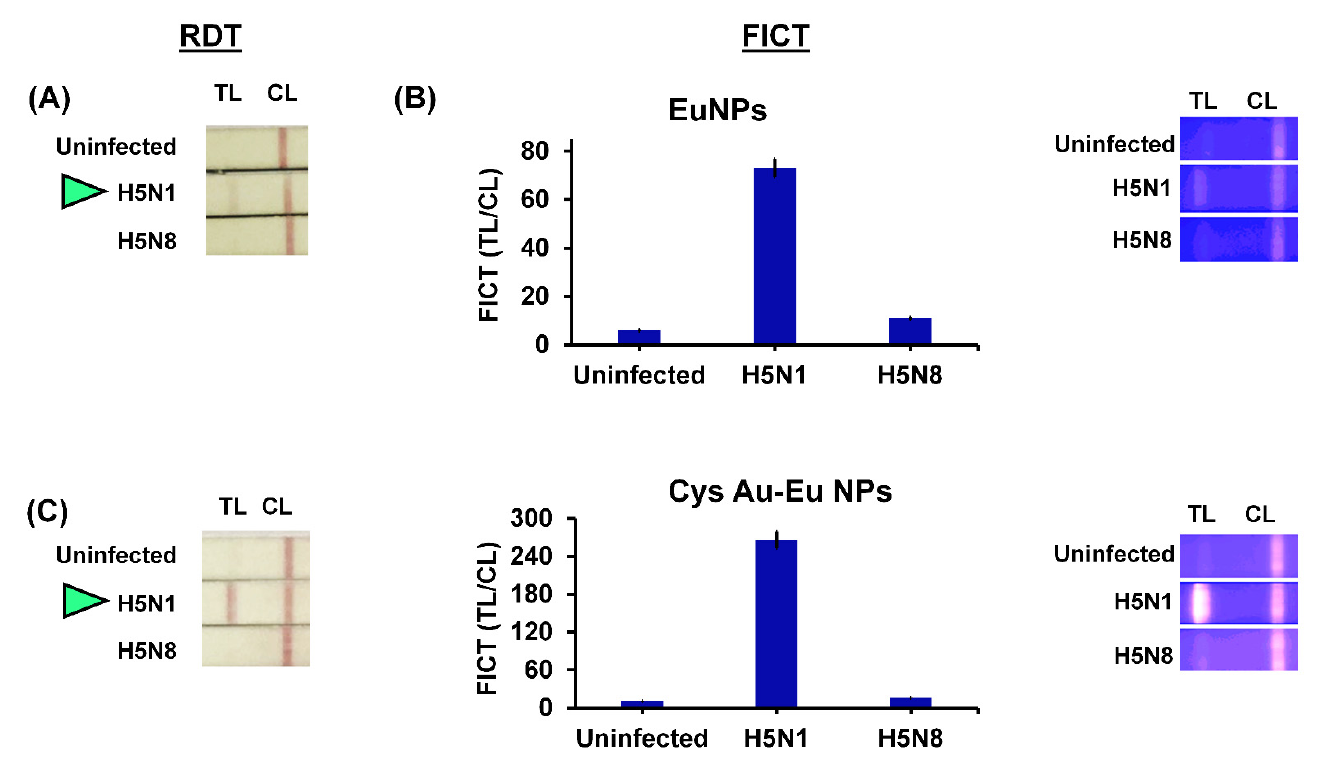
Figure 11. Comparison of the performance of nanomaterials tested for different H5 subtype viruses by FICT and RDT. ( A ) Commercial AuNPs—RDT; ( B ) Eu NP-FICT; and ( C ) Cys Au-EuNPs—RDT and FICT.